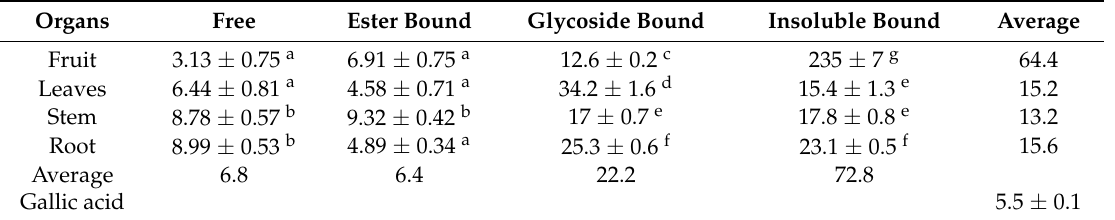
The values in each column or row with different alphabetical letters are significantly different at p <